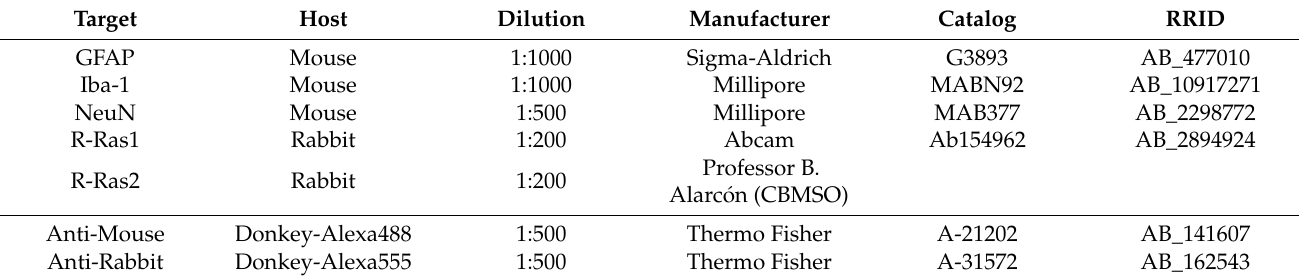
Table 4. Primary and secondary antibodies used for immunohistochemistry